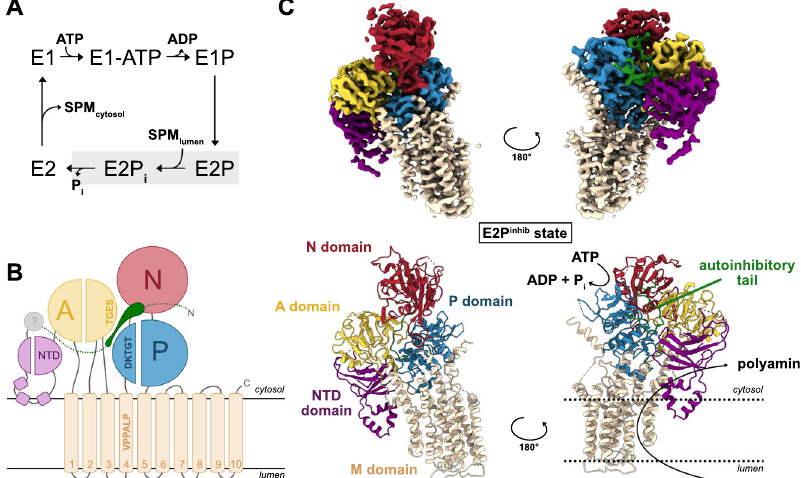
Fig. 1 Overall P5B-ATPase structure and topology. a The P5B-ATPase transport cycle likely follows the E1 – E1P – E2P – E2 Post-Albers scheme shown here, with the part of the focus in this work highlighted in gray. ATP consumption energizes the transport of polyamines such as spermine (SPM). b The P5B-ATPase topology, with ten transmembrane helices TM1 – 10 and the cytosolic A-, P-, and N-domains are conserved among P-type ATPases. The P5-speci fi c N-terminal domain (NTD, pink) harbors three short helices dipping into the membrane. Moreover, N-terminal residues form an auto- inhibitory tail (green) interacting with the A-, P-, and N-domains in the E2P inhib state. c EM density and cartoon representation of the E2P inhib conformation with contour level =